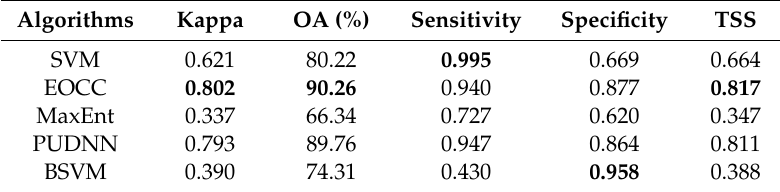
Table A3. Average overall accuracy, Kappa coe ffi cient, sensitivity, and specificity of the OCC methods and SVM in the transferability analysis. The best result of each accuracy metrics is